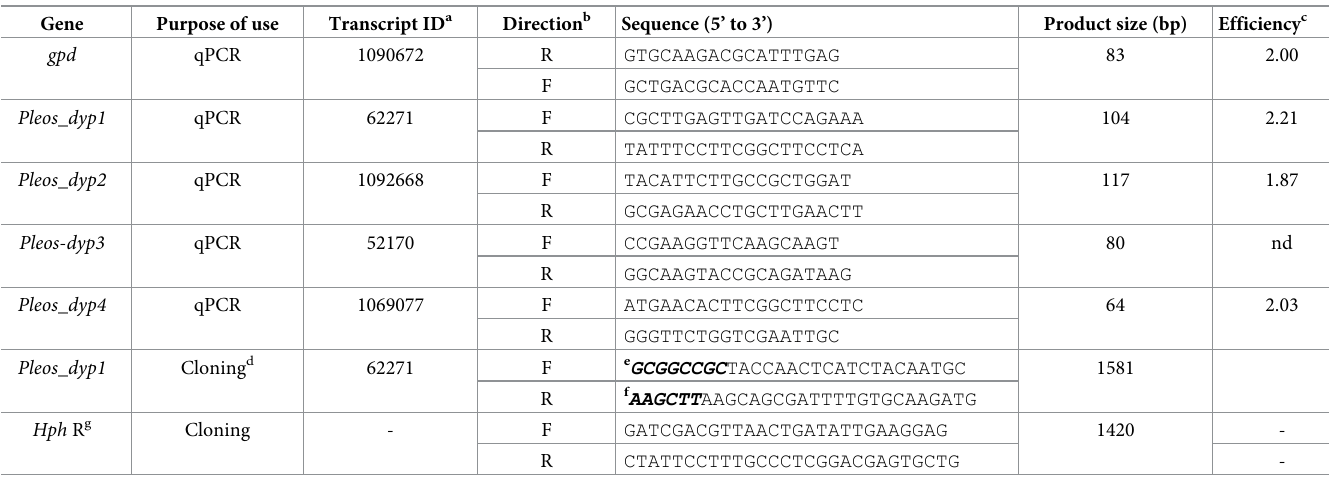
Table 1. Primers used in this